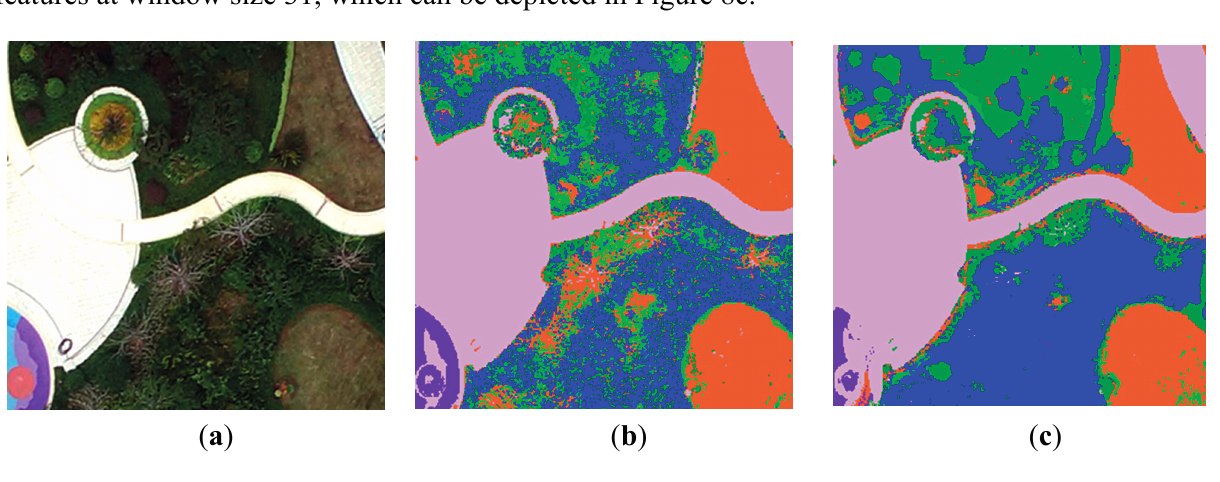
Figure 8. Details of classification result for RGB-only and RGB+GT31. ( a ) Original RGB image; ( b ) RGB-only; ( c )